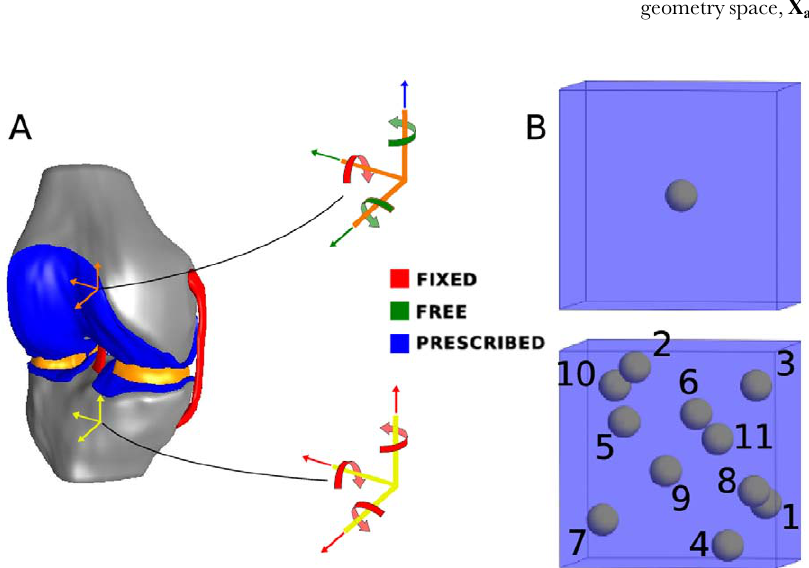
Figure 2. Macro and micro-scale models used in study. A . A model of the tibiofemoral joint was employed at the macro-scale. Boundary conditions were prescribed for the bones, modeled as rigid bodies, to approximate compressive loading of the joint. The tibia was fixed in space. Femoral compression was prescribed at fixed flexion with other degrees of freedom unconstrained. B . The single (top) and 11 cell (bottom) models. The single cell model was the popular scenario considered in previous studies [39], while the 11 cell model better represented the cell densities observed in situ for the middle layer of articular cartilage in the knee [40].